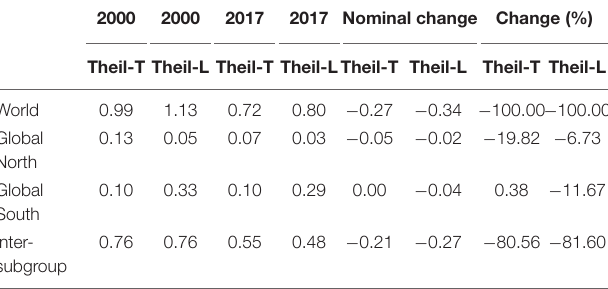
TABLE 1 | Decomposition of change in inequality for the North and South,